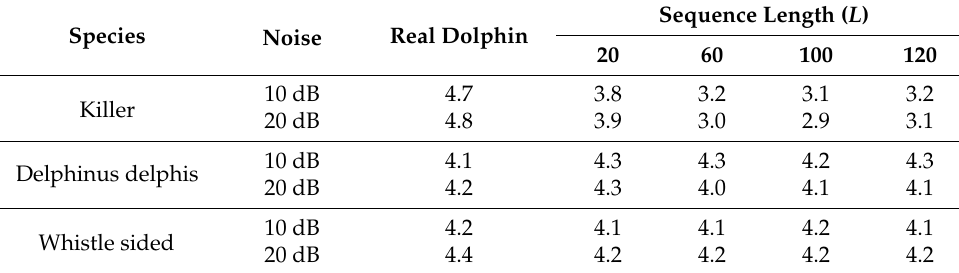
Table 5. Results of the 1st step DoM assessment.